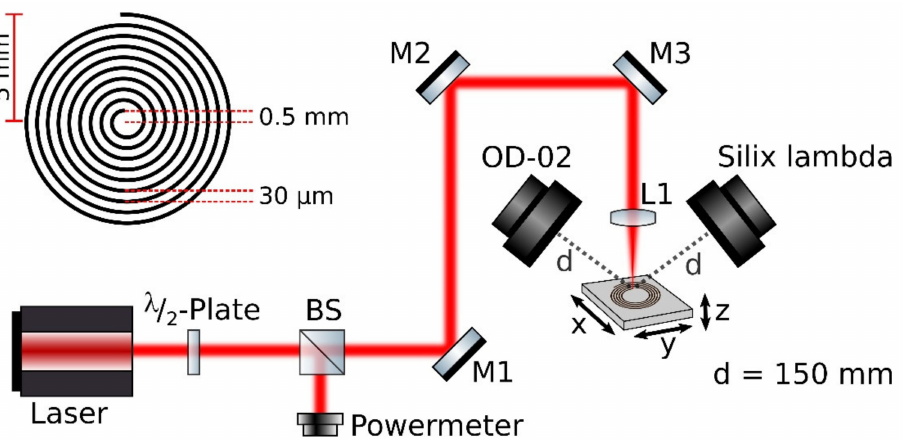
Figure 1. The schematic experimental setup is shown here. M1, M2, M3—Dielectric mirrors; L1— Plano-convex lens (f = 60 mm); BS—beam splitter. The schematic image of the spiral patterning on the material formed during the laser micromachining is shown in the left top. A power meter is used to verify the laser power used for the laser